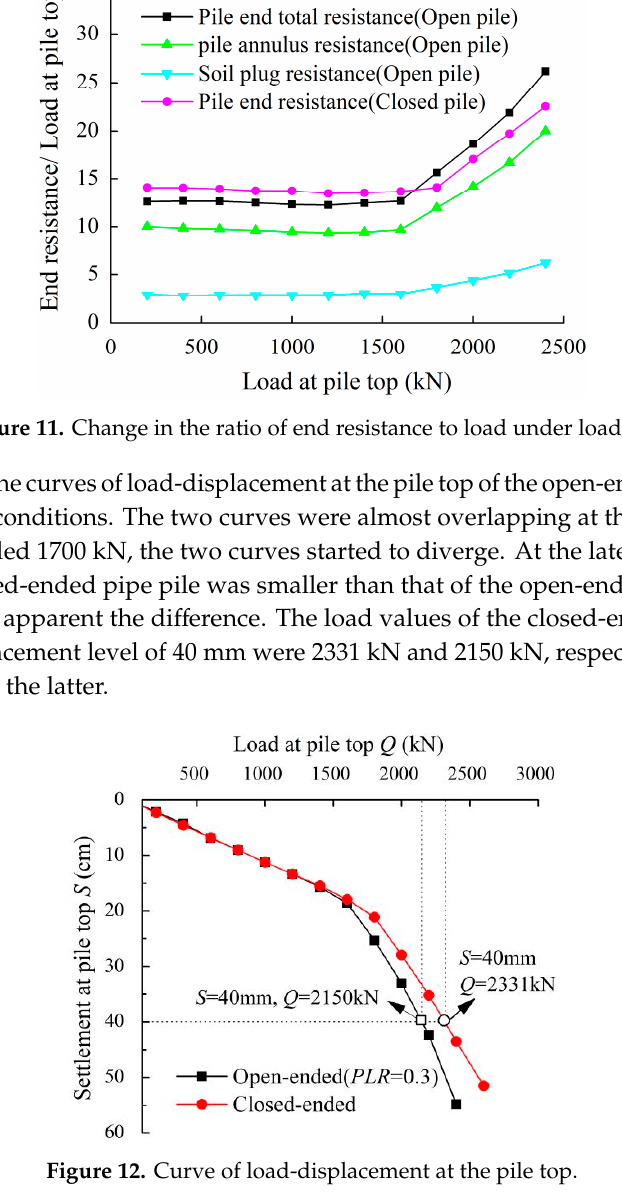
Figure 10. Distribution of internal skin friction under loading.